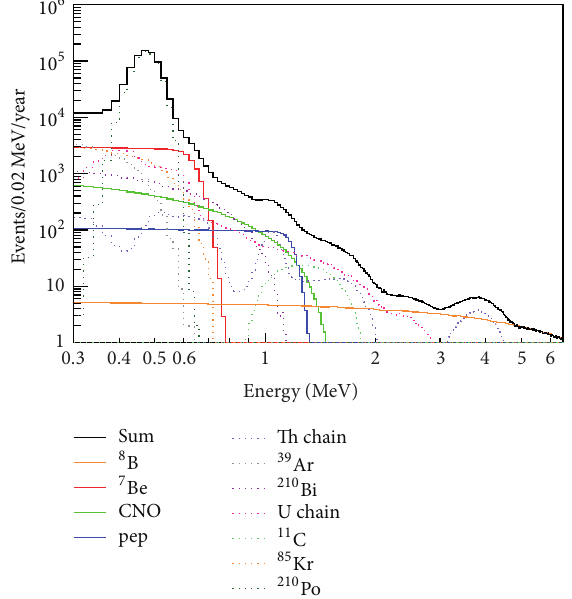
Figure 7: Expected solar neutrino fluxes as detected by SNO+ and the corresponding main backgrounds. Backgrounds levels are assumed to be equal to those initially achieved by Borexino [20, 25] (see text). Events are shown for the LAB-PPO scintillator, 400 Nhits/MeV light yield, and a fiducial volume cut of 5.5 m. A 95% reduction is applied to the 214 Bi-Po backgrounds via delayed coincidence tagging, and a 95% reduction on the 210 Po and the remaining 214 Po events via alpha